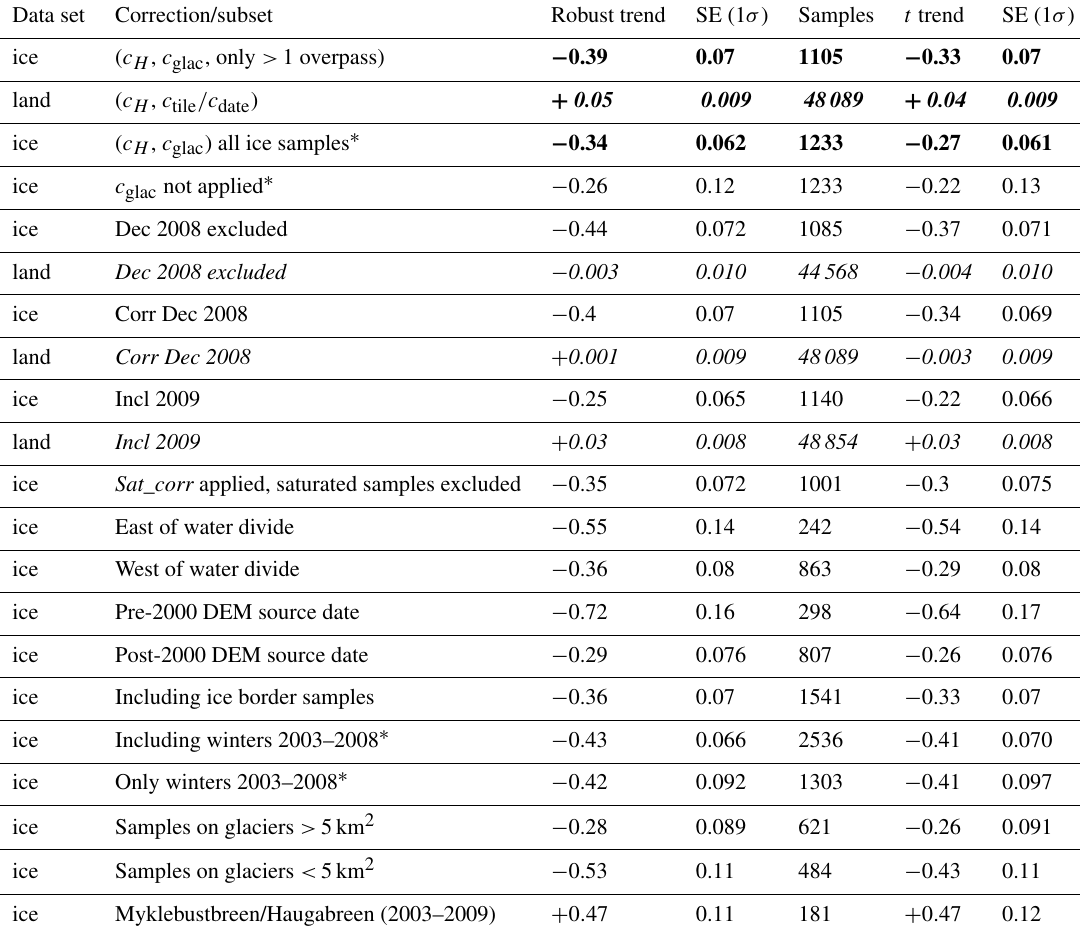
Table 1. Trends and trend standard error (SE), as computed from different subsets and corrections applied to the data set ( c H , c tile and c glac are applied unless specified otherwise). Footprints on glaciers sampled only during one autumn campaign are excluded except for the subsets marked with an asterisk, i.e. ∗ corresponds to all 2003–2008 (autumn) ice samples. In bold are final estimates for the whole of southern Norway. Italicized are values for land